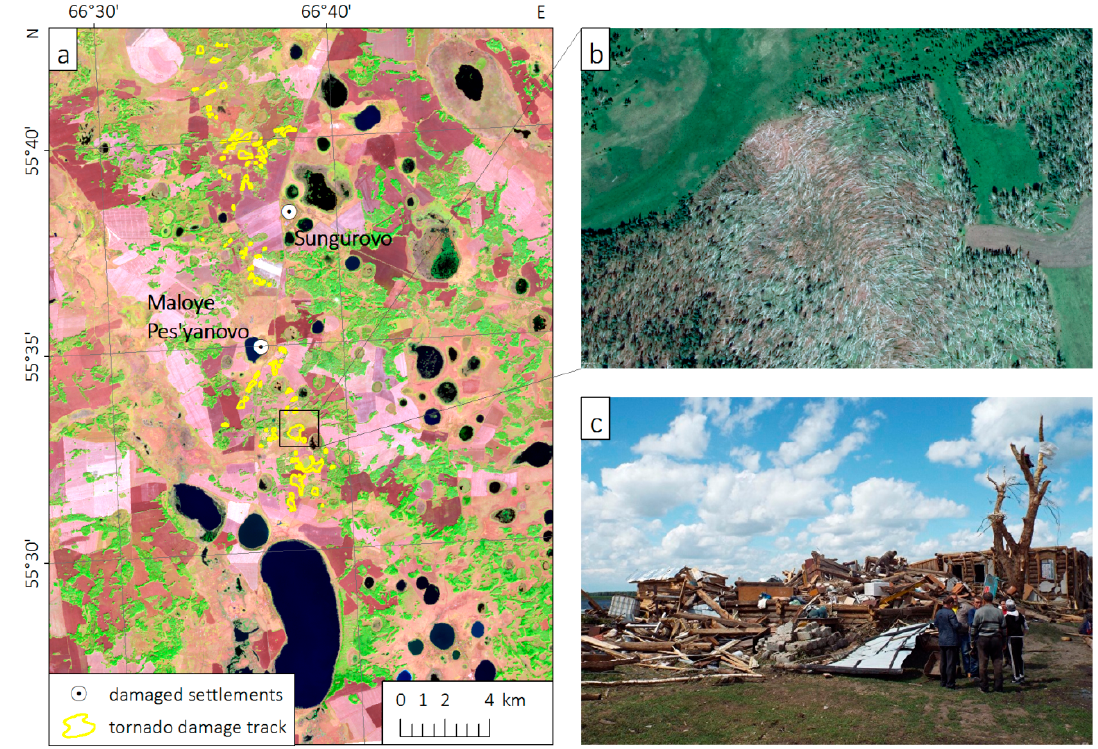
Figure 8. Forest damage track caused by the IF4 tornado of 18 June 2017 passed through Maloye Pesyanovo village ( a ), high-resolution image of related damage in forest ( b ), and photo of destroyed log-houses and debarked tree in Maloe Pesynovo village ( c ).